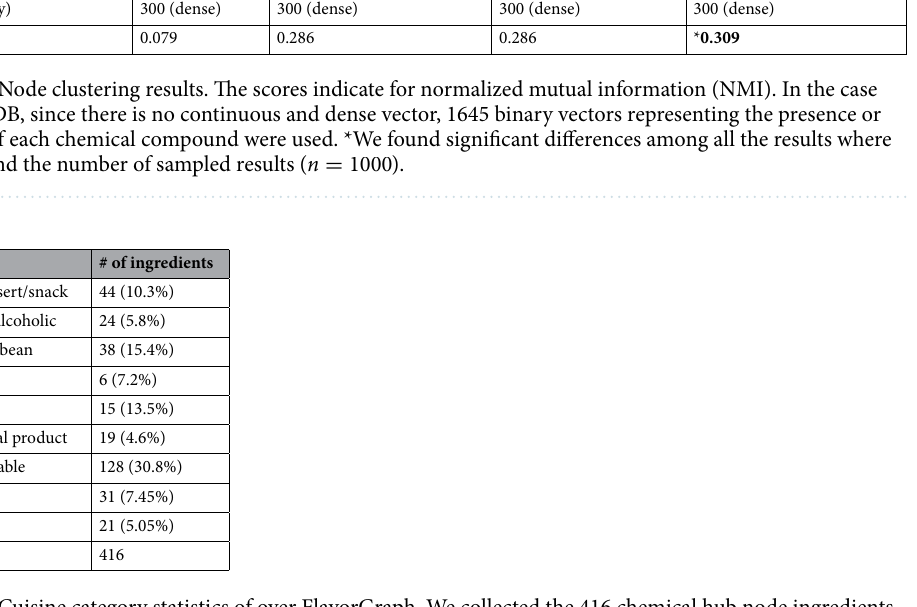
Table 3. Cuisine category statistics of over FlavorGraph. We collected the 416 chemical hub node ingredients, which co-exist in FlavorDB and other baselines models where they contain chemical compound information for category clustering.